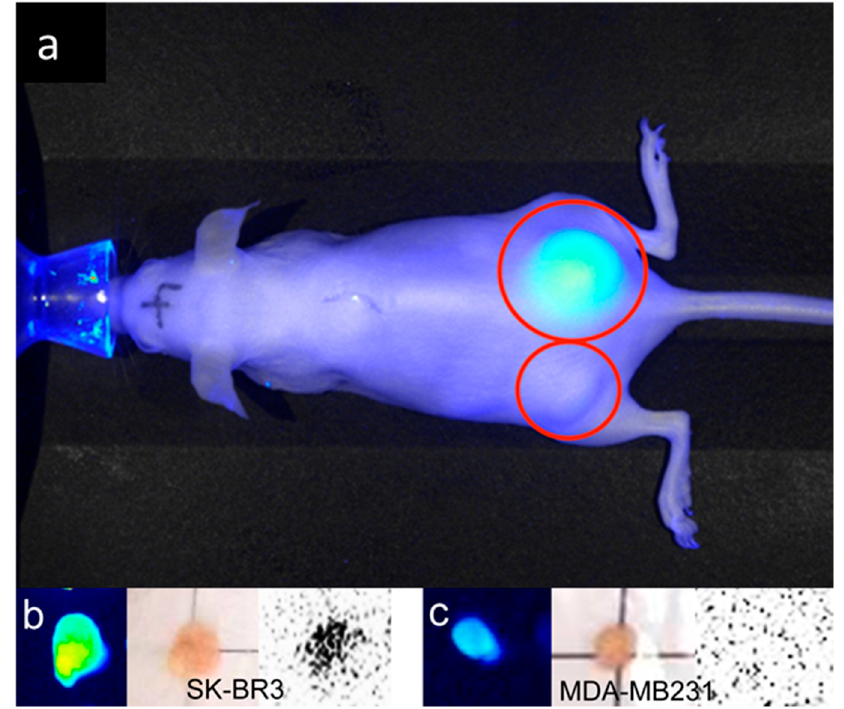
Figure 9. Xenografted tumors image with 99m Tc-diethylenetriamine pentaacetic acid (DTPA) dual-imaging probe (red circles). In vivo imaging of tumor xenograft mice with use of DTPA used dual-imaging probe. The NIR image showed a high-intensity fluorescence in the SK-BR3 tumor ( right dorsum , a ) in contrast to the MDA-MB231 tumor ( left dorsum , a ). Excised SK-BR3 tumors ( b ) exhibit a higher fluorescence intensity and radioactivity in contrast to the MDA-MB231 tumor ( c ). The size of the SK-BR3 tumor is 11 mm × 8 mm × 2 mm and the size of the MDA-MB231 tumor is 6 mm × 5 mm × 5 mm ( b , c ).